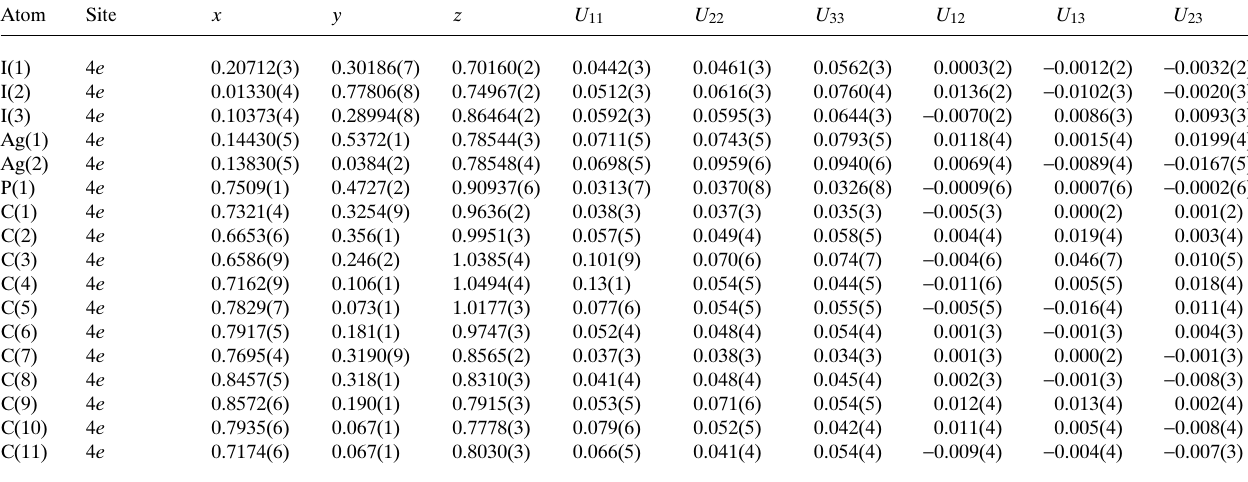
Table 3. Atomic coordinates and displacement parameters (in Å 2 ) .